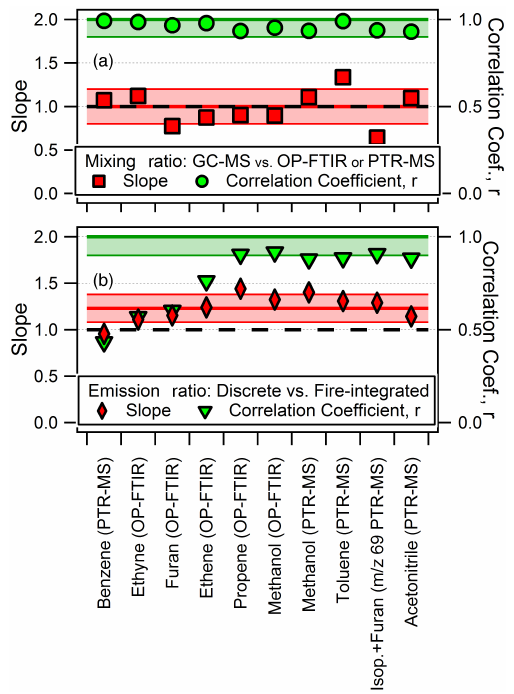
Figure 2. Slopes and correlation coefficients, r, determined from correlation plots of (a) mixing ratios measured by the GC-MS ver- sus the average mixing ratio measured by the OP-FTIR or PTR-MS during the GC-MS sample acquisition time and (b) discrete vs. fire- integrated emission ratios of select VOCs relative to CO as mea- sured by the OP-FTIR or PTR-MS. The black dashed line represents slopes equal to 1. The average of the slopes and the standard devi- ation is shown by the red shaded bands. The green bands represent r > 0 . 90.